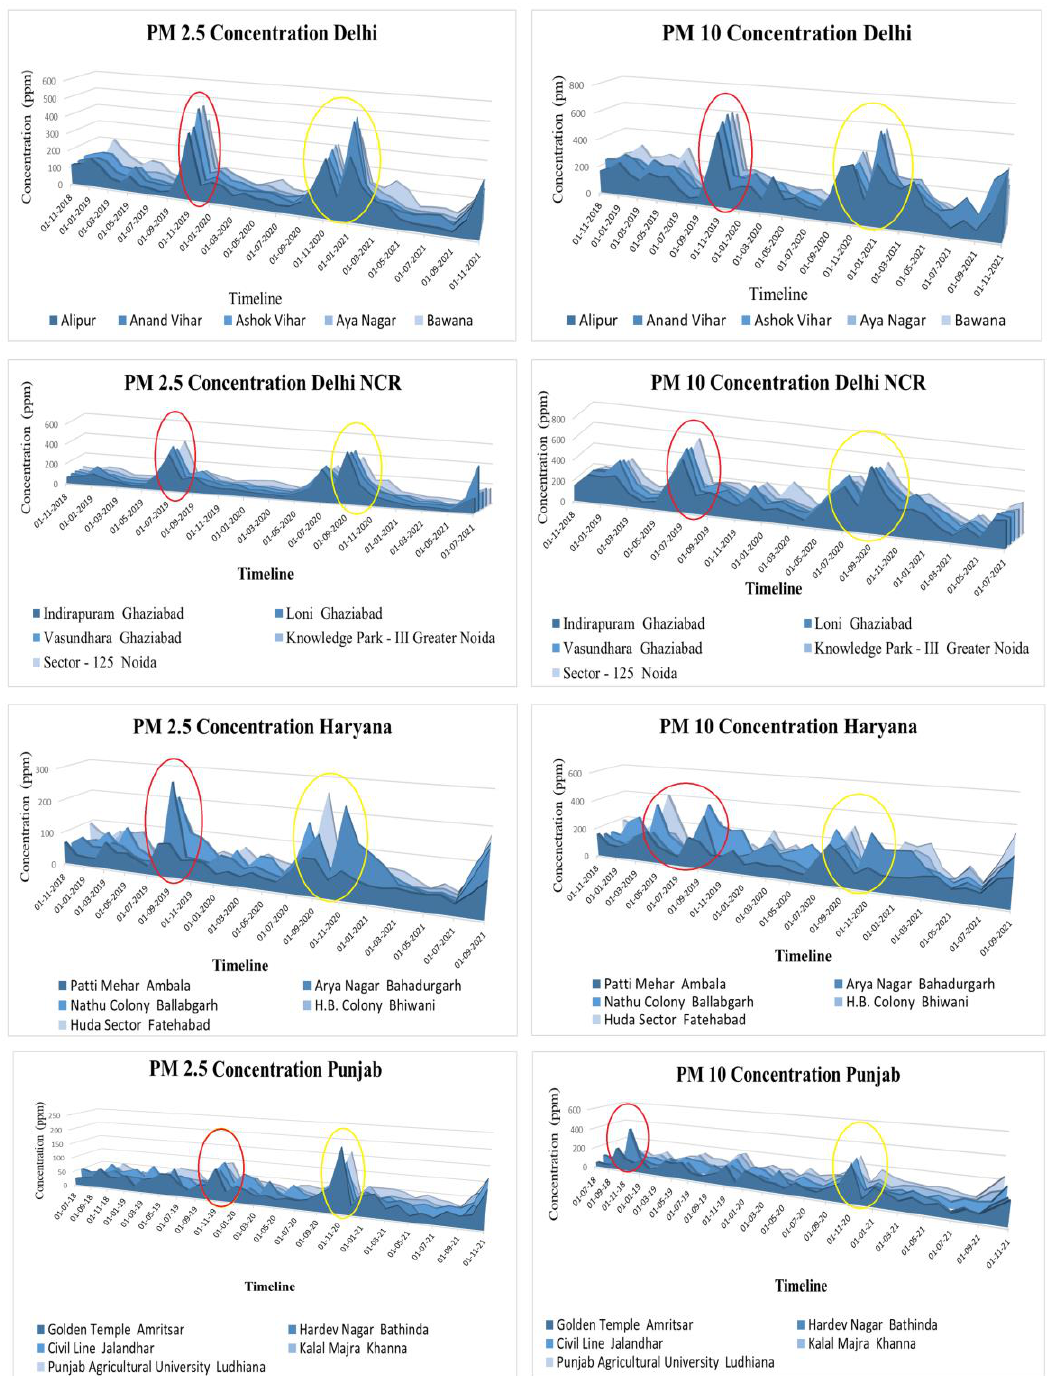
Figure 12. Showing the concentration of PM 2.5 and PM 10 in ambient air of the study site in Delhi, Uttar Pradesh (Delhi NCR), Haryana, and Punjab.